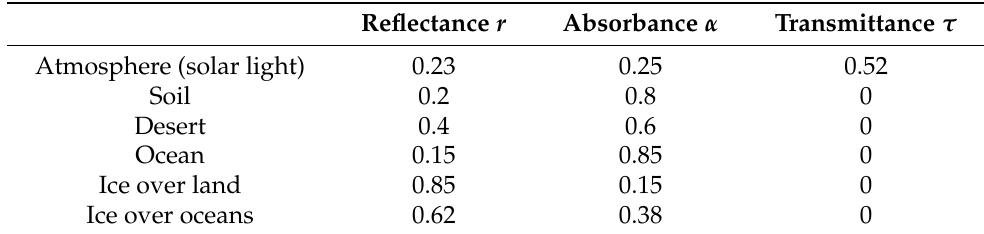
Table 3. Reflectance r , absorbance α and transmittance τ of solar radiation for various thermodynamic bodies on